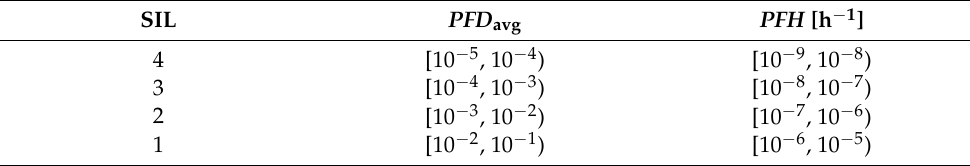
Table 1. SIL probabilistic